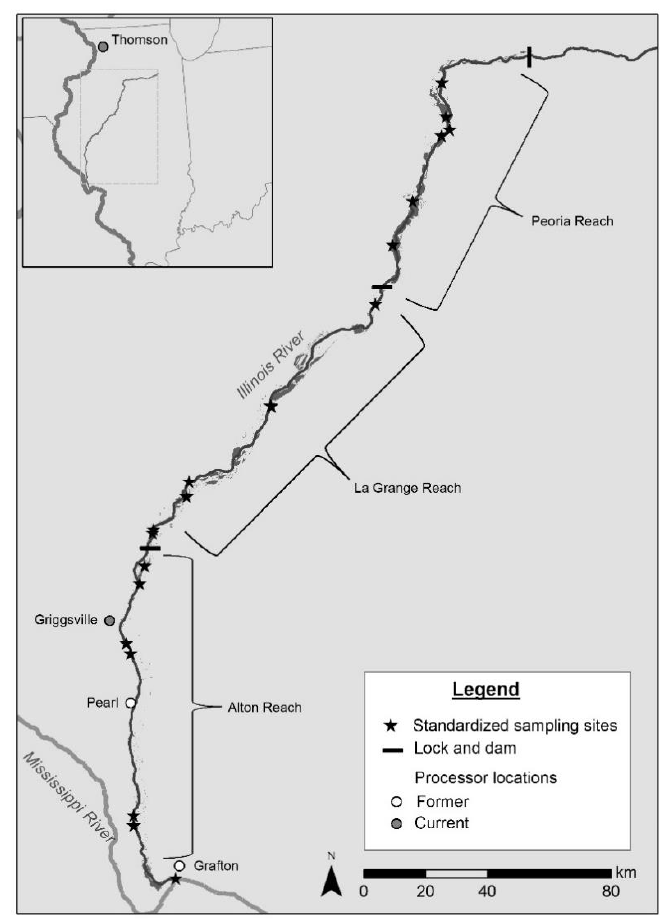
Figure 2. Map of the Illinois River study areas and processing plants during the 2011–2012 study period. Note that Griggsville became non-operational at an unknown time since the study concluded.